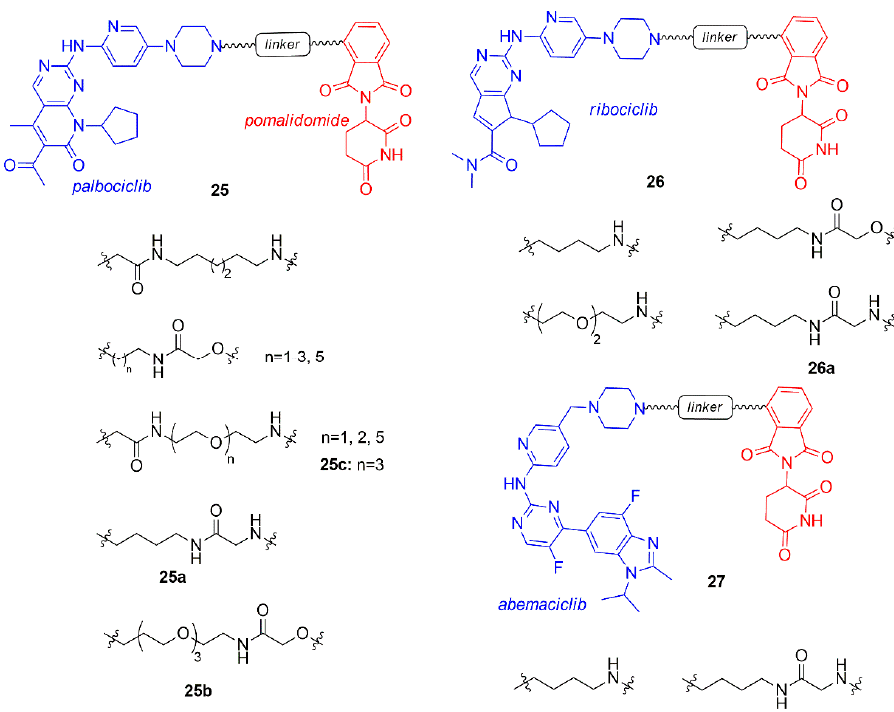
Figure 16 . PROTACs containing CDK4/6 inhibitors and pomalidomide synthesized by Jiang et al. PROTACs of each CDK4/6 inhibitor demonstrated degrading activity of both CDK4 and 6, but abemaciclib-PROTACs also induced the degradation of the off-target